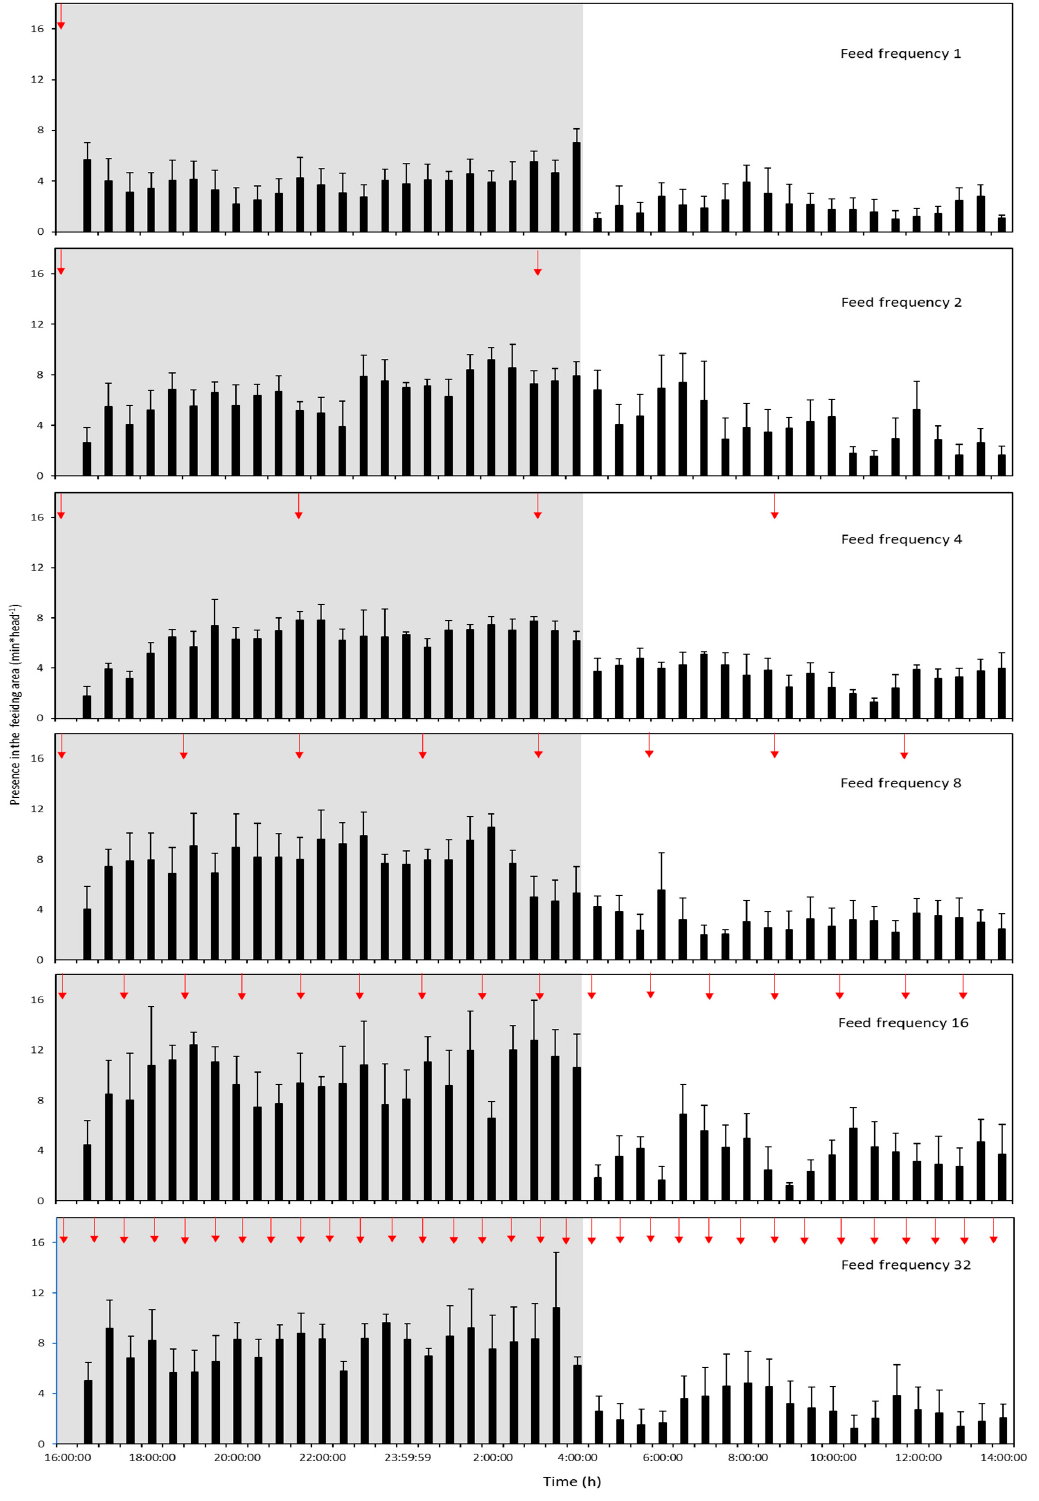
Figure 4. Lobster presence in the feeding area (min × head − 1 ) shown for all tested feeding frequencies. Red arrows indicate feed delivery events. Error bars denote S.E.